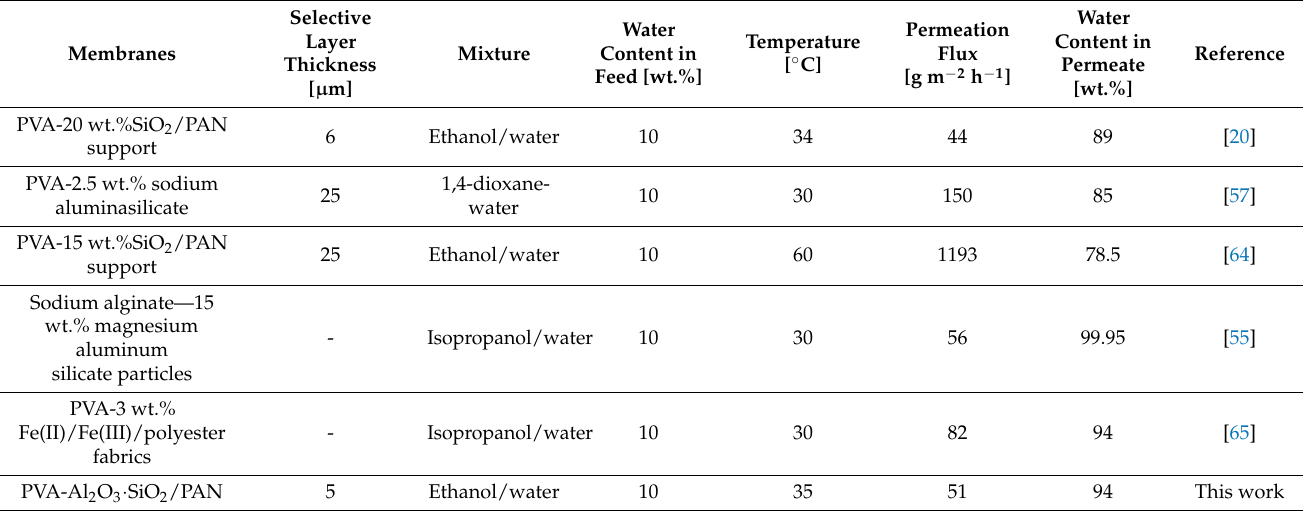
Table 5. The comparison of the transport properties of nanoparticle modified membranes for dehy- dration by